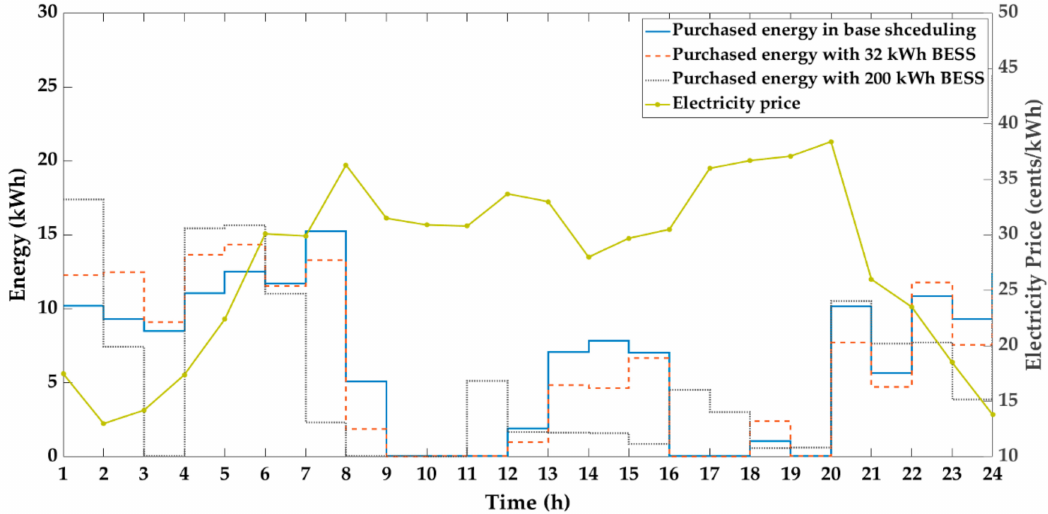
Figure 5. Energy purchased from the utility